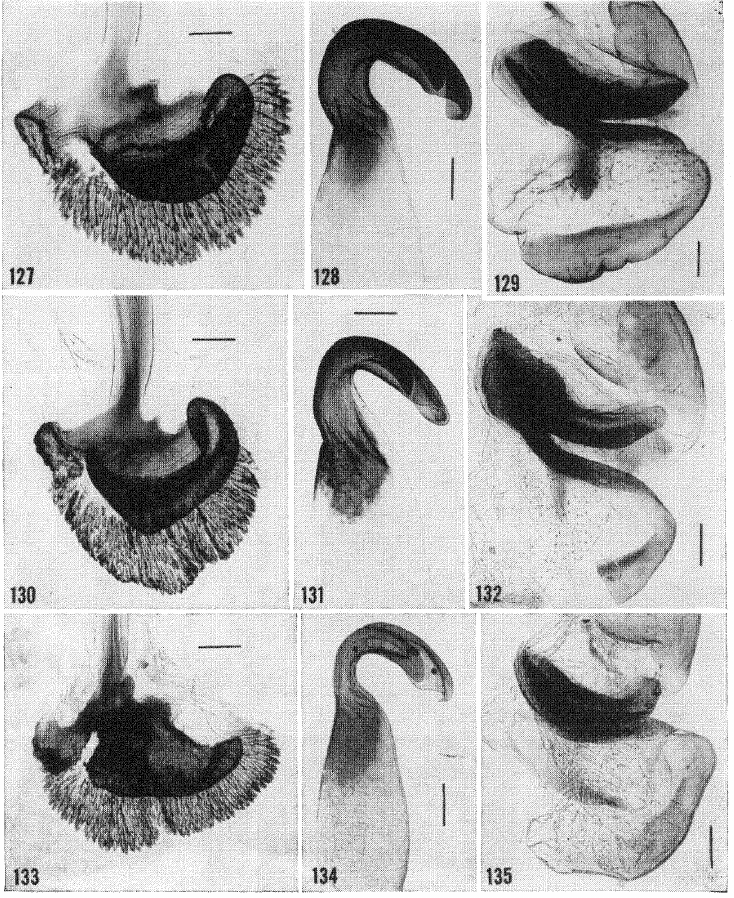
Figs. 127-135. 127-129. (963 L). Monaslria similis (from specimen shown in Fig. 122). 130-132. (52 USNM). Monastria sp. possibly similis. So Paulo, Brazil (det. Gurney). 133-135. (10 ANSP). Monastria bigut- tara. (from specimen shown in Fig. 121). (scale 0.3